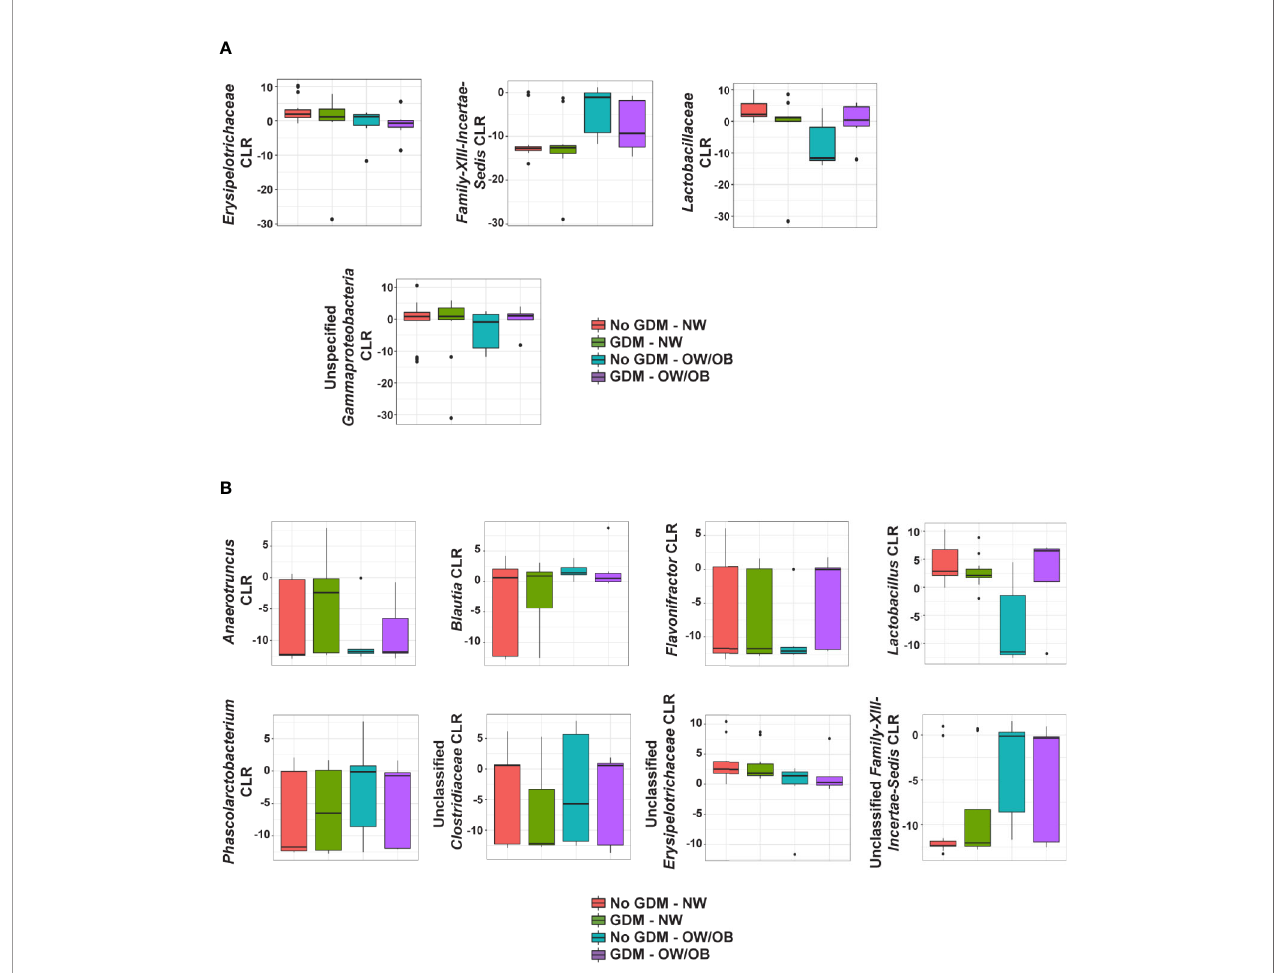
FIGURE 2 | Summary of the impact of maternal GDM on infant gut microbial taxa in the interaction model. Box plots of centered log ratio (CLR) transformed (A) family- and (B) genus-level taxa counts by maternal GDM status and weight group. Taxa displayed are those whose relationship in infants from mothers with GDM differed signi fi cantly based on maternal weight group. GDM, gestational diabetes; NW, normal-weight; OW/OB,